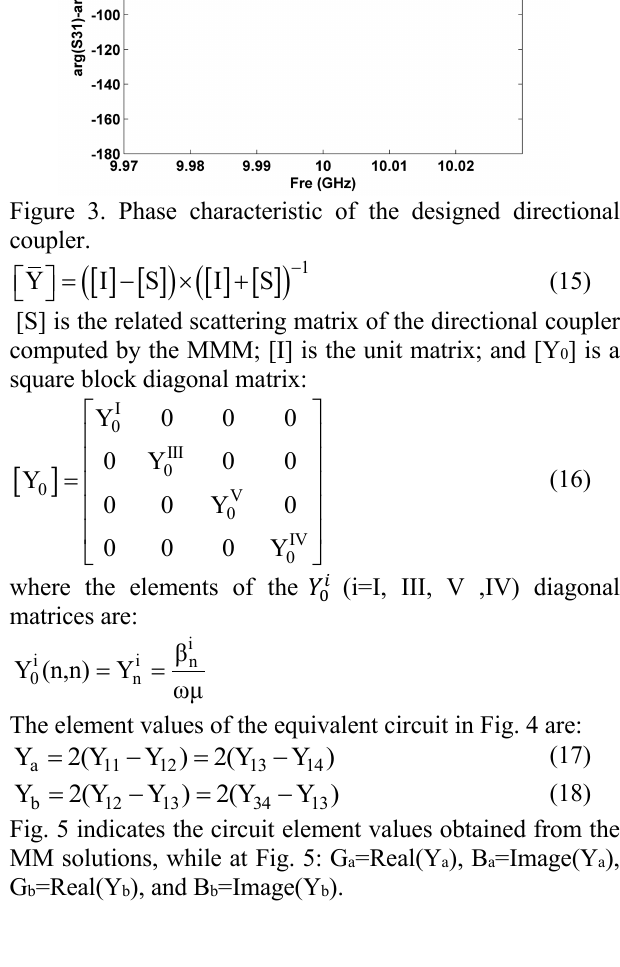
Fig. 5 indicates the circuit element values obtained from the MM solutions, while at Fig. 5: G a =Real(Y a ), B a =Image(Y a ), G b =Real(Y b ), and B b =Image(Y b